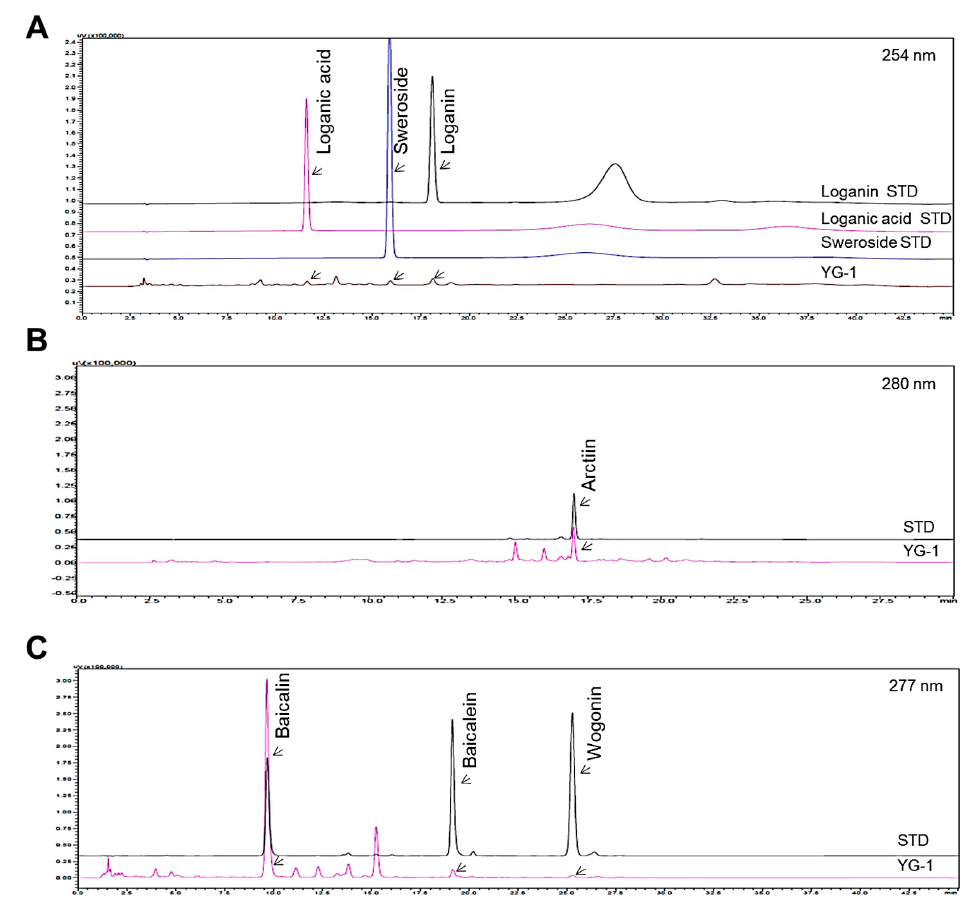
Figure 2. HPLC chromatograms showing peaks corresponding to the marker compounds, loganin, loganic acid, sweoside ( A ), arctiin ( B ), baicalin, baicaein, and wogonin ( C ) of YG-1 extract. HPLC, high performance liquid chromatography.